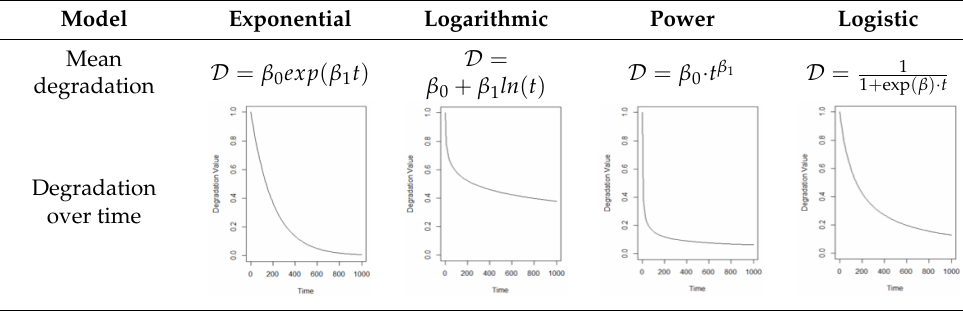
Table 1. Mean degradation path models applied to ADDT of springs. Model Exponential Logarithmic Power Logistic Mean degradation